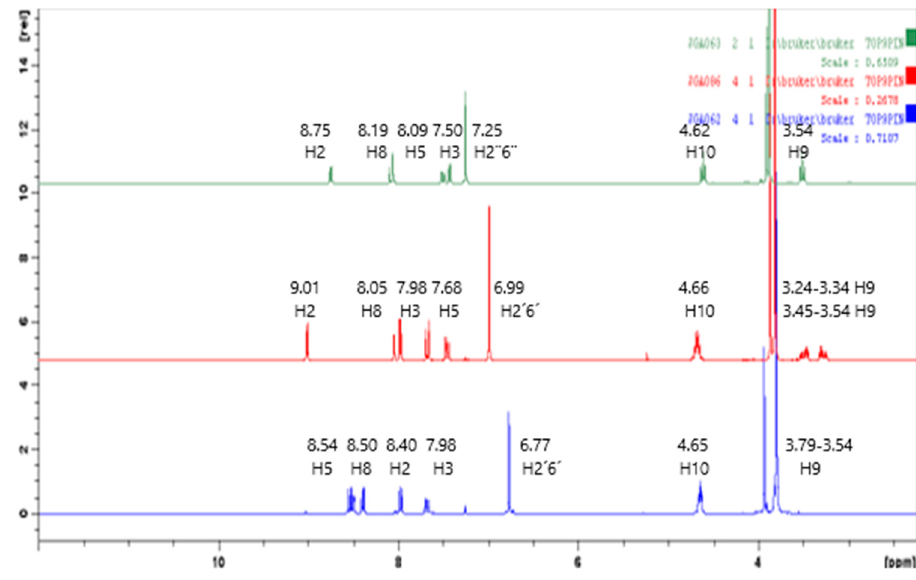
Figure 2. 1 H NMR spectra of compounds 14 , 46 , 67 .